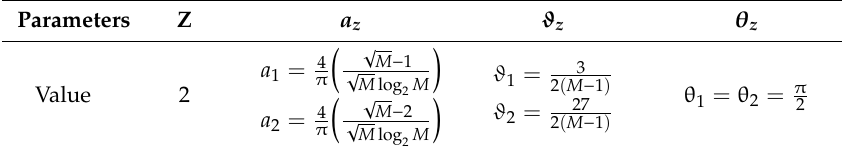
Table 1. M -quadrature-amplitude-modulation ( M -QAM)